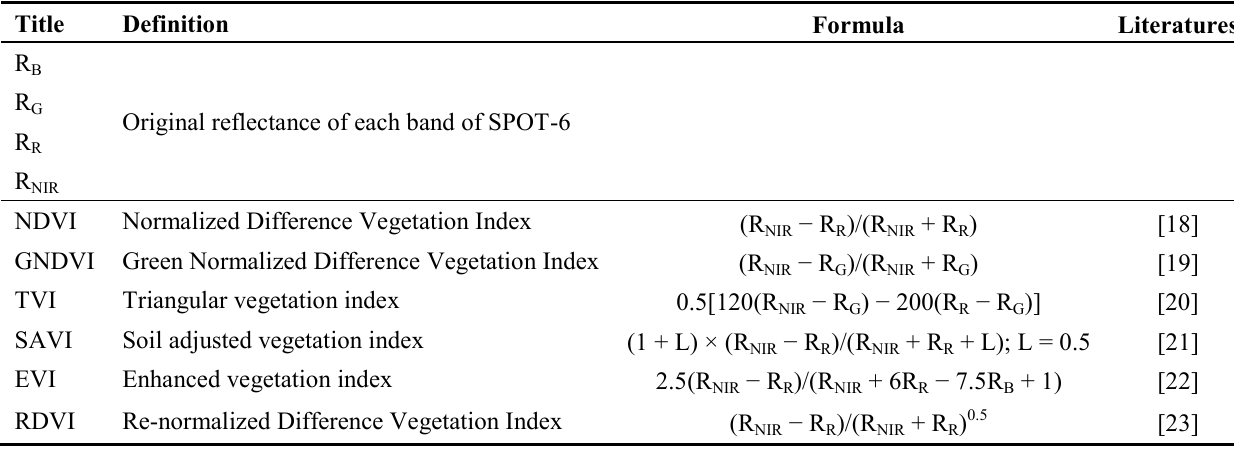
Table 3. Indices tested in this study for mapping powdery mildew.